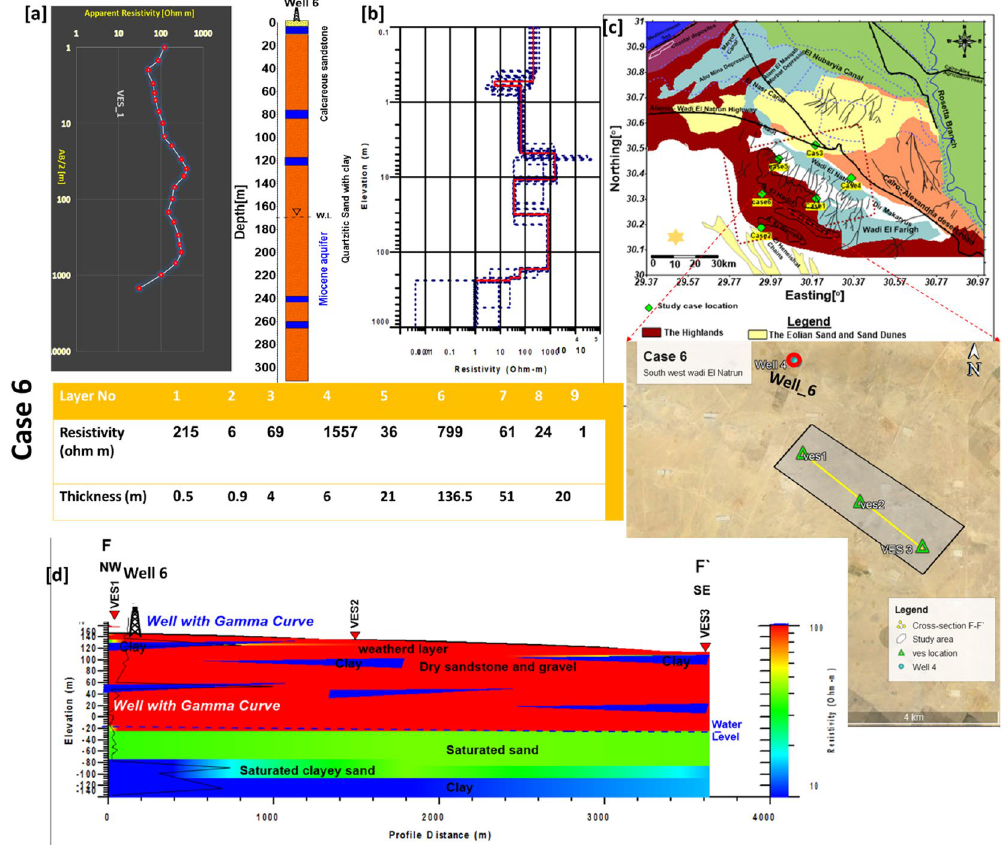
Figure 10. ( a ) VES1 as example for case 6 with Well 6, ( b ) inverted model with cumulative models, ( c ) the location of F–F ′ cross section in the study area, ( d ) inverted resistivity cross section F–F ′ in the sixth study